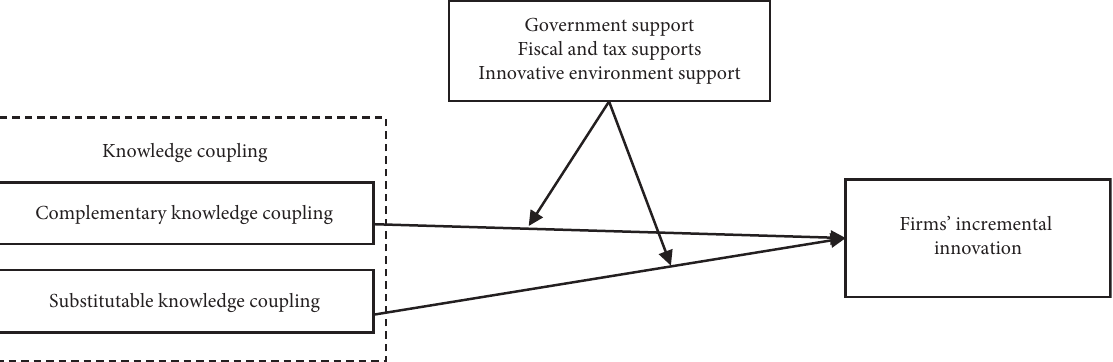
Figure 1: The conceptual model of this